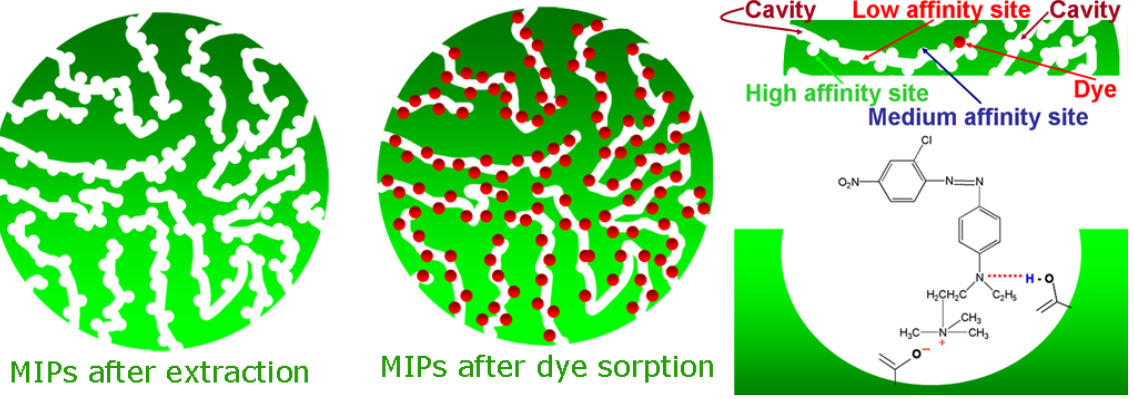
Figure 1. Example for the synthesis of Molecular Imprinted Polymers (MIPs) for capturing/binding dye